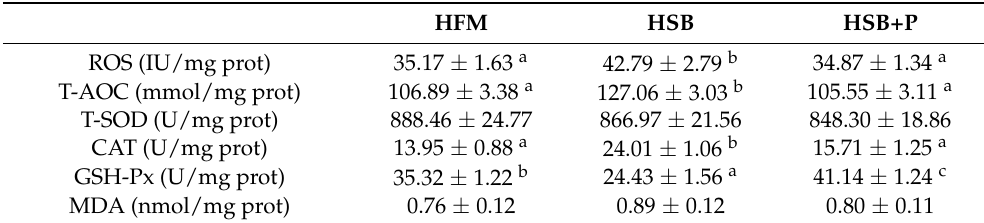
Table 7. Effects of experimental diets on hepatic antioxidant capacity of largemouth bass (Mean ± SEM, n = 8).